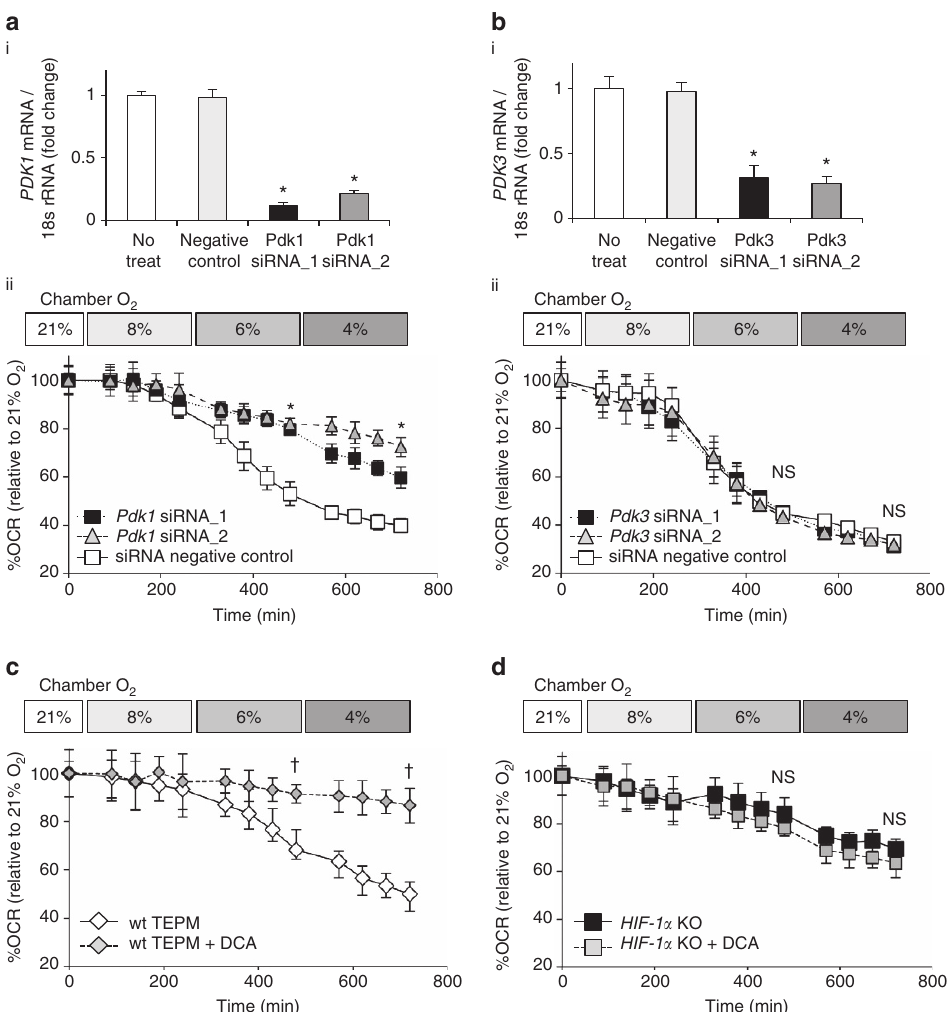
Figure 3 | The essential role of HIF-1 a - PDK1 axis in hypoxia-induced glycolytic reprogramming. ( a , b ) (i) The relative expression of Pdk1 or Pdk3 in RAW 264.7 cells with gene silencing by siRNA. (ii) OCR of RAW 264.7 cells treated with Pdk1 or Pdk3 siRNA of under mild hypoxia (8% O 2 , 4h-6% O 2 , 4h-4% O 2 , 4h). ( c , d ) OCR of TEPMs treated with DCA (10mM), a chemical inhibitor of PDK, under mild hypoxia (8% O 2 , 4h-6% O 2 , 4h-4% O 2 , 4h). All graphs indicate average with s.d. All experiments using XF24 were repeated three times. Student’s t -test was performed to calculate P value. * P o 0.05 versus control (negative control); w P o 0.05 versus control (untreated); NS, not significant; wt TEPM, Tie2-Cre (cid:2) / (cid:2) HIF-1 a flox/flox mice; HIF-1 a KO, Tie2-Cre þ / (cid:2) HIF-1 a flox/flox mice; DCA ; 21, 8, 6 and 4% O 2 concentration,